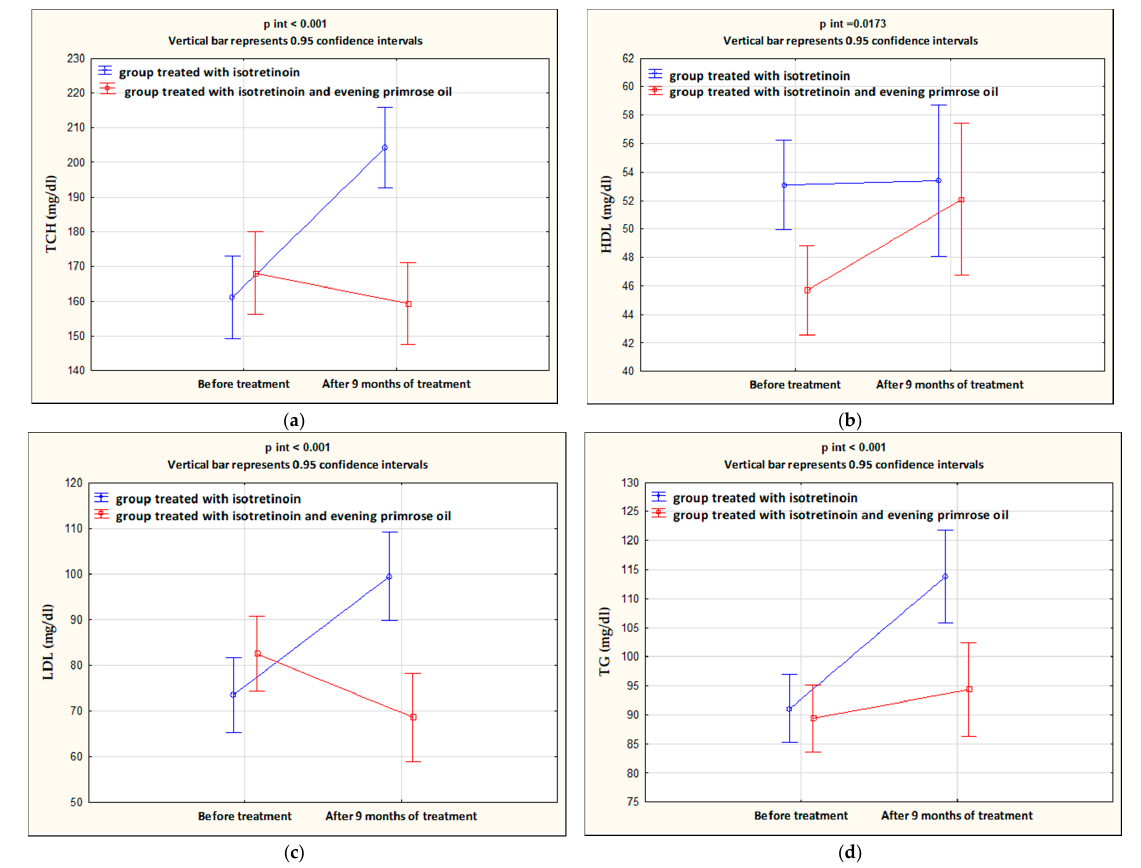
Figure 3. Changes in concentrations of TCH ( a ), HDL ( b ), LDL ( c ), and TG ( d ) in the groups treated with isotretinoin or isotretinoin and evening primrose oil. Table 4. Percentage of subjects in groups I and IOW for which the analyzed parameters were within or outside the reference ranges.